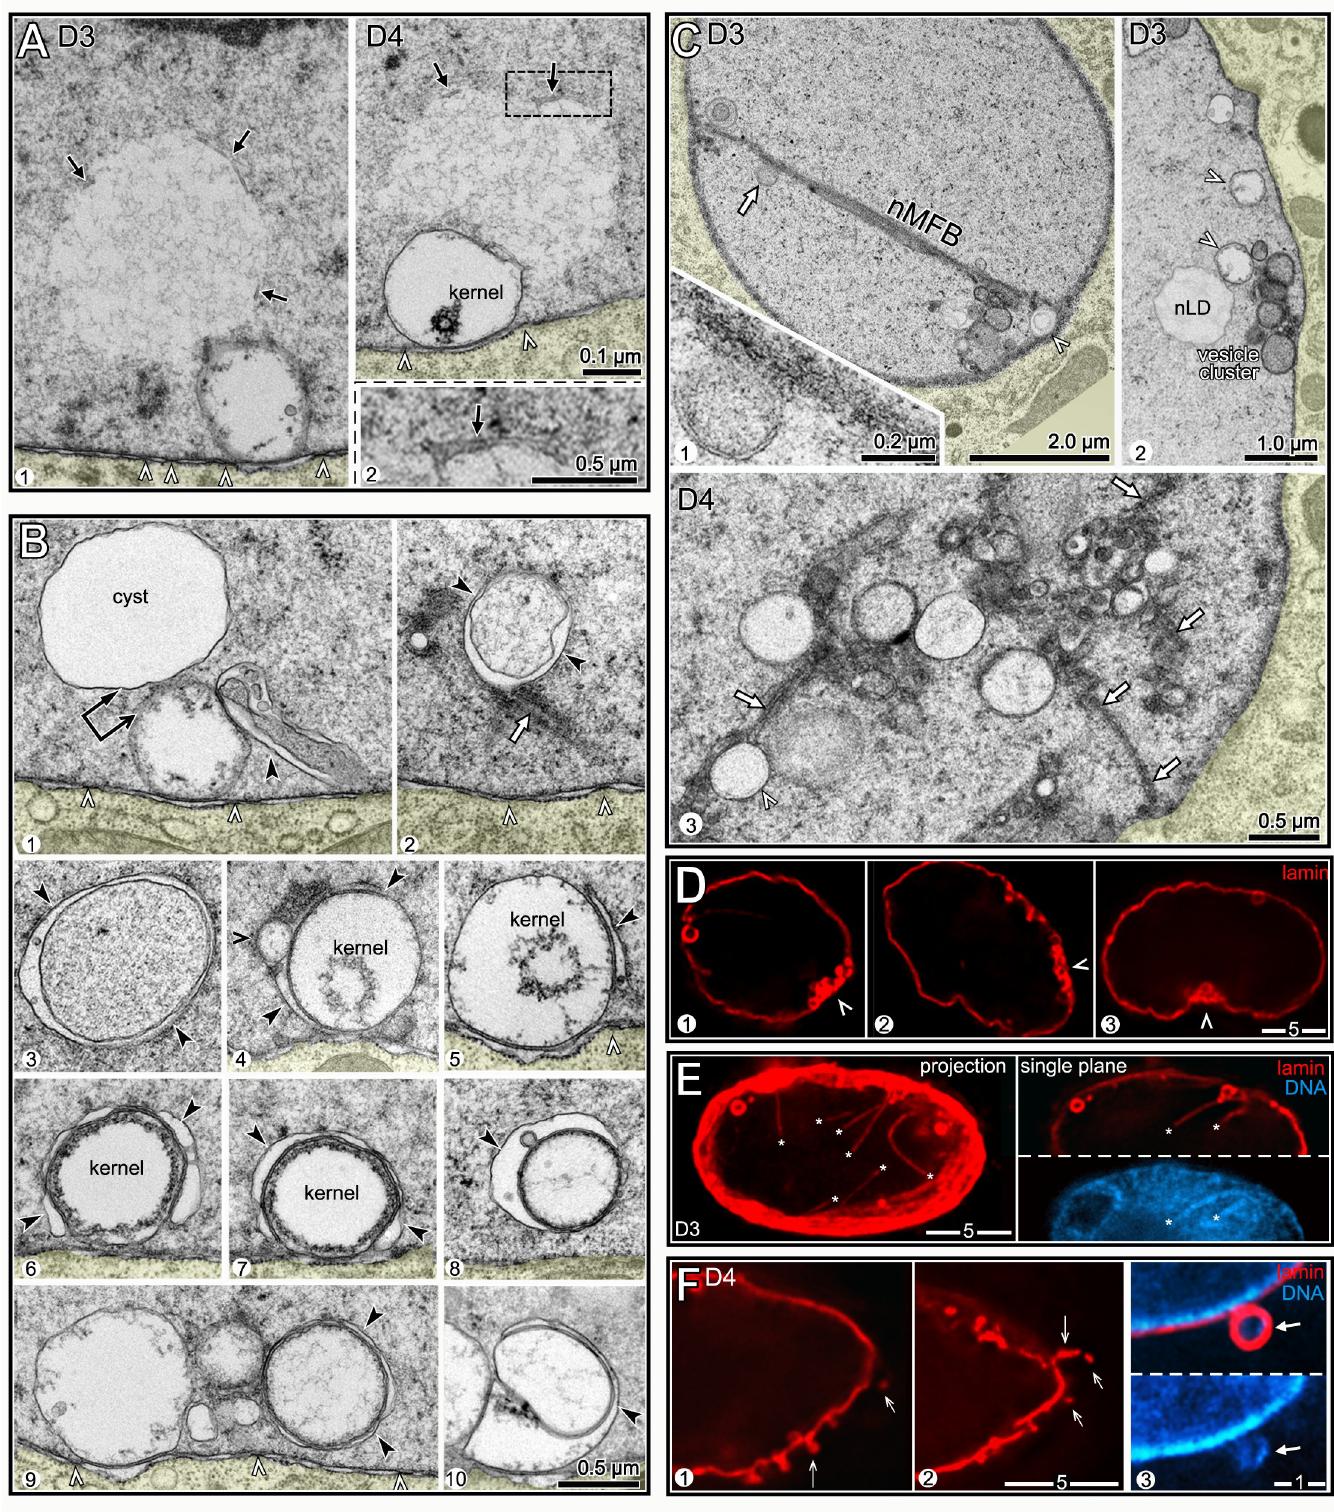
Fig 8. Degradation/engulfment of nuclear vesicles and nLDs. (A) TEM of D3 and D4 nuclei. Each nucleus contains a large region of atypical nucleoplasm that is partially surrounded by membrane fragments and that is adjacent to a membrane vesicle. The vesicles are identified as degraded kernel vesicles by their size, position,